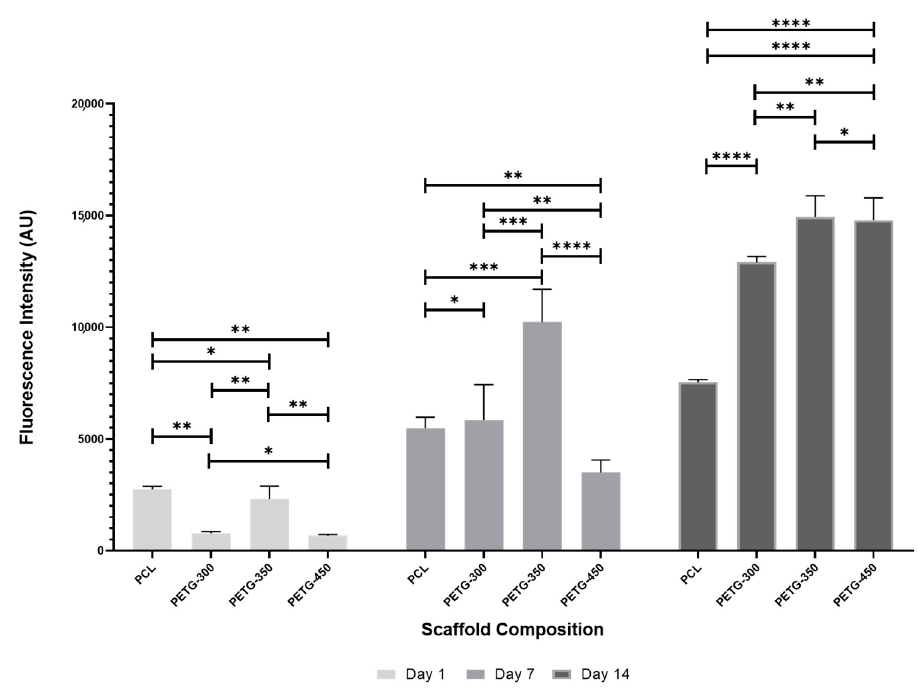
Figure 6. Alamar Blue results for both PCL and PETG scaffolds at days 1, 7 and 14 post-cell-seeding. * Statistical evidence ( p < 0.05) analyzed by one-way analysis of variance (ANOVA) and Tukey’s post-test. The * Statistical evidence ( p < 0.05), **, *** is the one-way analysis of variance (one-way ANOVA) and Tukey’s post hoc test with the use of GraphPad Prism software and it is used to show the difference be-tween the results. The * is small difference and while more * are added the differences between the results are higher.